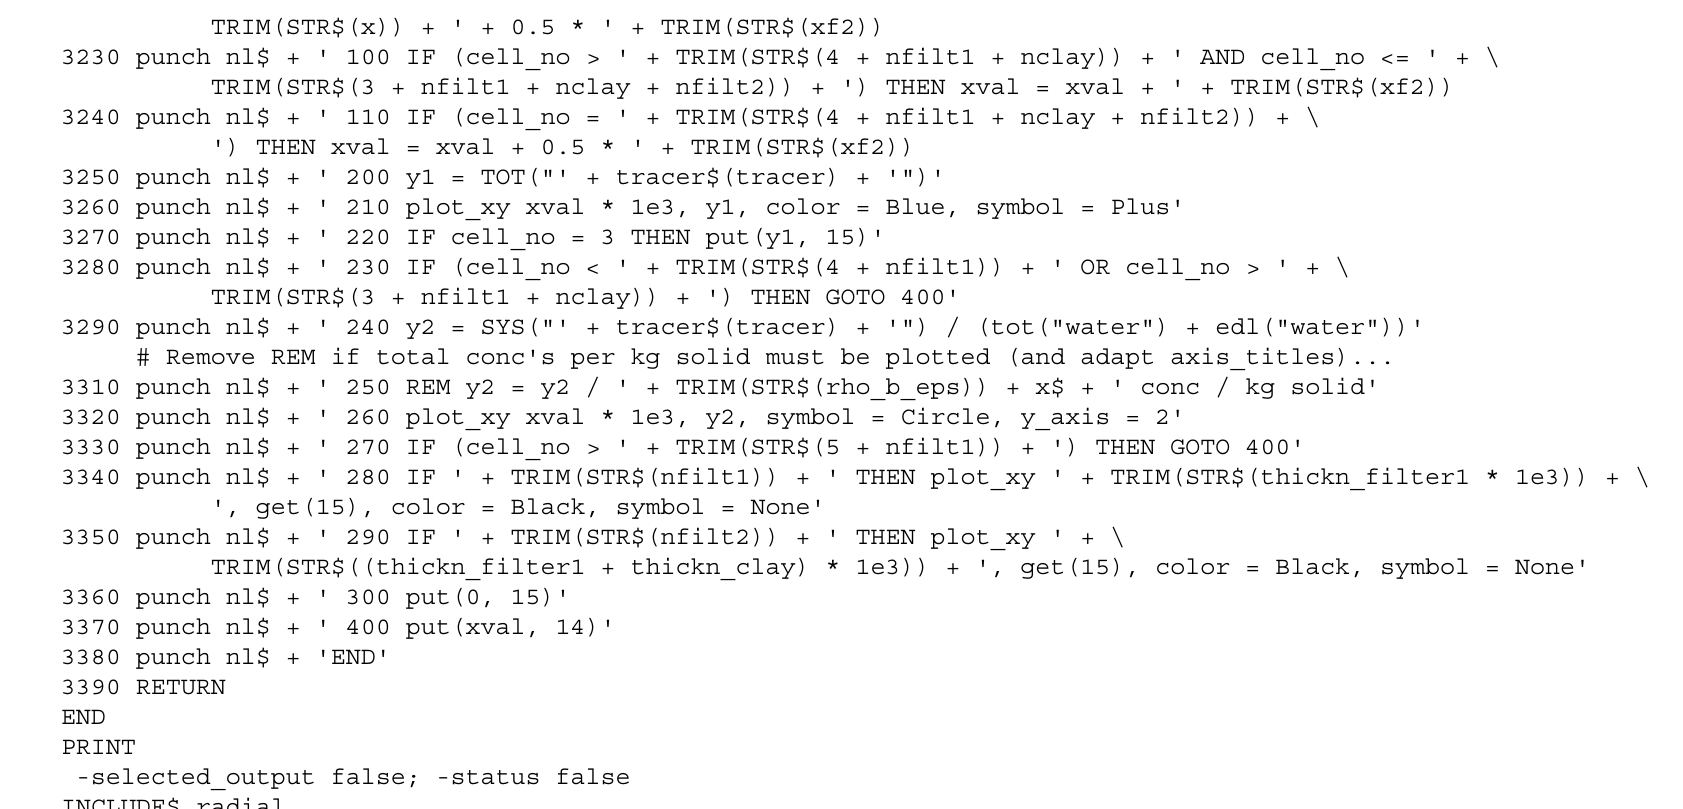
Table 60. Input file for example